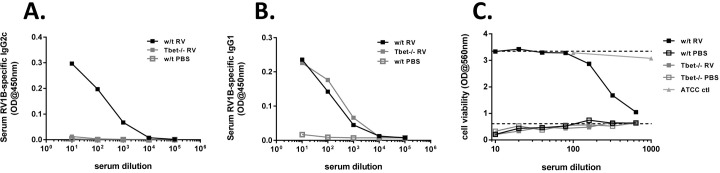
RV-specific antibody responses in Tbet deficient and wild type mice.Wild type and Tbet-/- mice were infected intranasally with RV1B or sham infected with PBS. Blood was collected 14 days after infection. (A&B) RV1B-binding IgG2c (A) and IgG1 (B) in sera was measured by ELISA. (C) Neutralisation of RV1B infection of Ohio HeLa cells by pooled sera assessed by crystal violet cell viability staining. ATCC ctl: control reference guinea pig anti-sera. Top dashed line in C, uninfected cells control. Bottom dashed line in C, RV infected cells control. Data represent results from 5–6 pooled sera per treatment group in a single experiment, representative of 3 independent experiments.